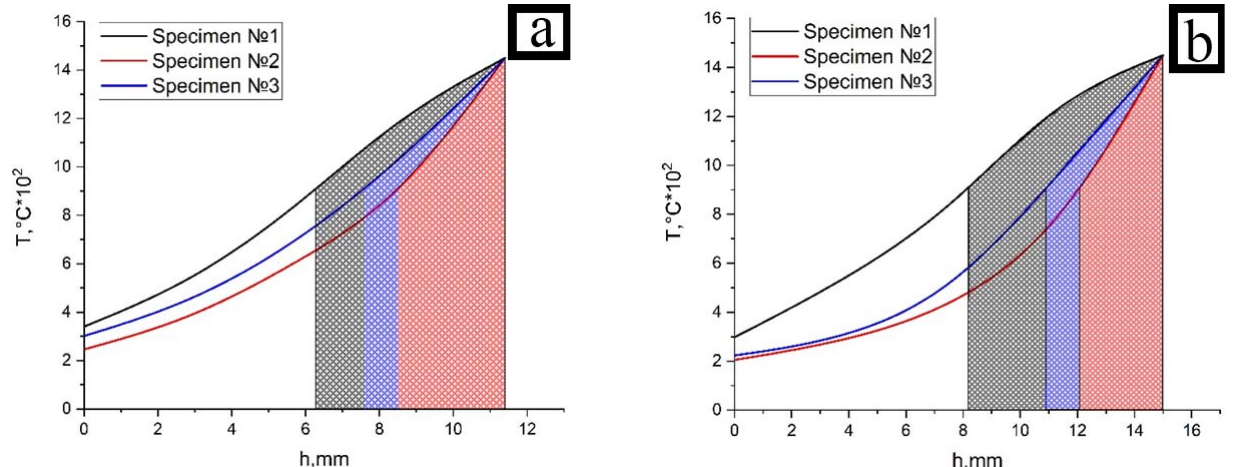
Figure 5. The results of numerical modeling the thermal pattern along the height of the cross-sectional view of workpieces: ( a ) in the central part; ( b ) at the extreme lateral part. The proportion of material in the central part of specimen № 1, which is in the tem- perature range of the formation of the γ -Fe phase, is 1.34 times greater than in specimen